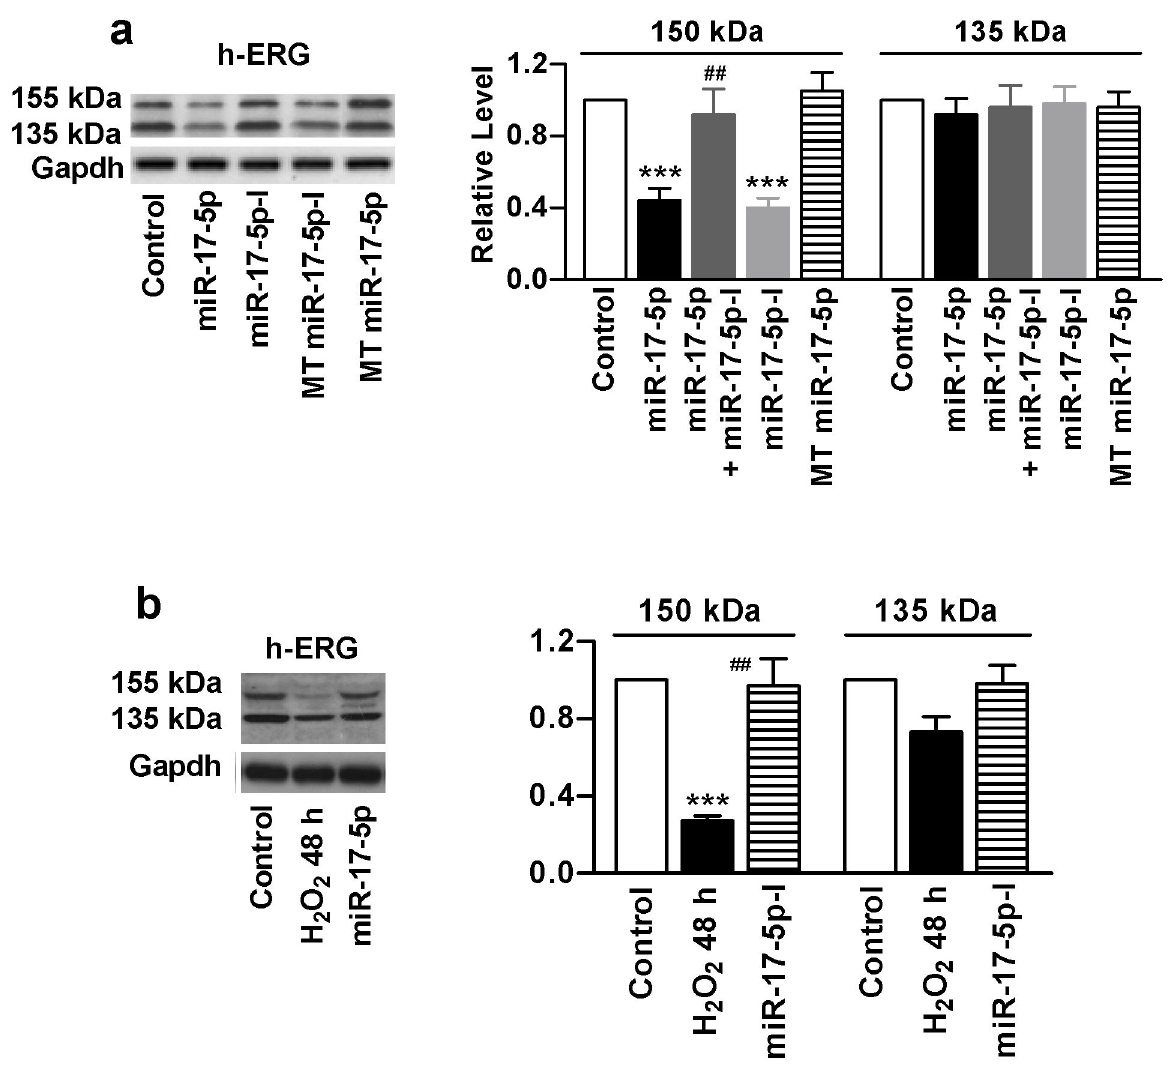
Figure 5. Direct effects of miR-17-5p on h-ERG trafficking in h-ERG-expressing HEK293 cells. (a) Effects of exogenously applied miR-17-5p mimic on h-ERG trafficking assessed by Western blot analysis. miR-17-5p-I: miR-17-5p inhibitor (co-transfected with miR-17-5p mimic); MT miR-17-5p: mutant miR-17-5p. *** P <0.001 miR-17-5p vs Control; ### P <0.001 miR-17-5p-I vs miR-17-5p; n=6; (b) Effects of miR-17-5p-I on oxidative stress-induced trafficking disruption of h-ERG. *** P <0.001 H miR-17-5p-I vs H O ; 2 2